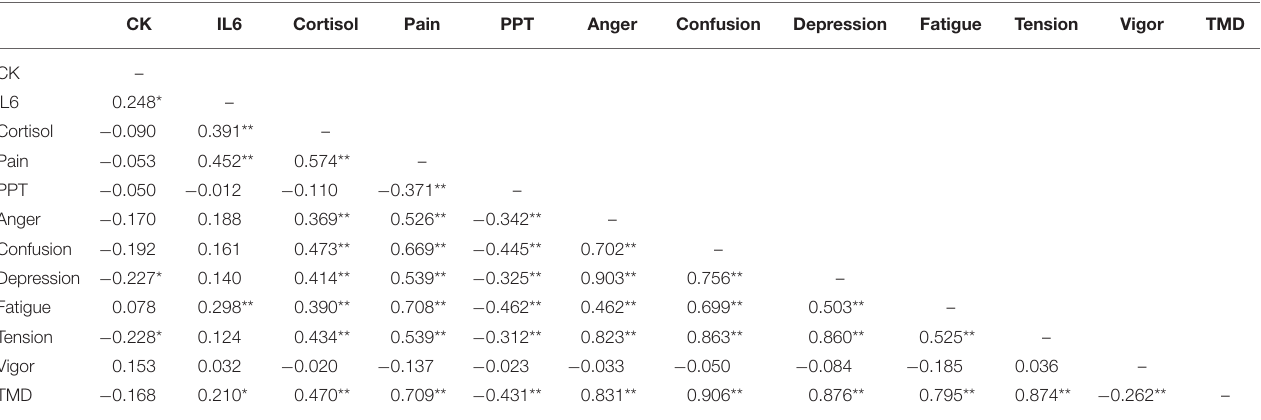
TABLE 4 | Correlation among measurements of muscle damage, muscle pain, and mood states. CK IL6 Cortisol Pain PPT Anger Confusion Depression Fatigue Tension Vigor